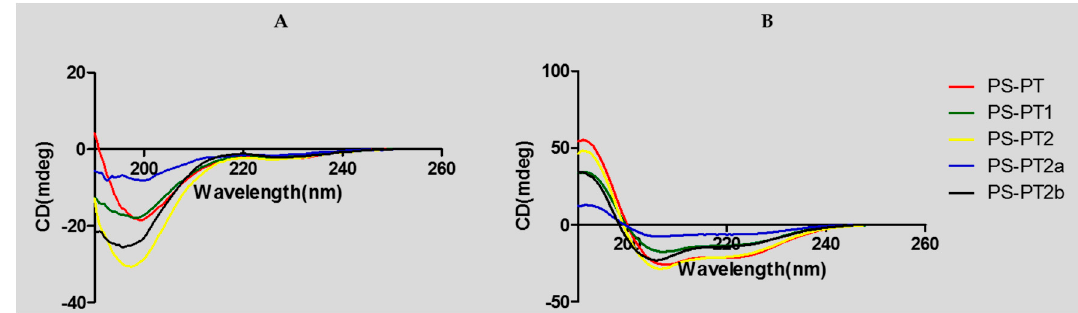
Figure 5. Circular dichroism (CD) spectra of PS-PT and its analogues (100 μ M) ( A ) in 10 mM ammonium acetate water solution and ( B ) in 50% 2,2,2-trifluoroethanol (TFE)/10 mM ammonium acetate water solution. Table 1. The amino acid sequences of PS-PT and analogues with their physicochemical parameters. The predicted secondary structures of PS-PT, PS-PT1, and PS-PT2 are shown below each peptide sequence, respectively. D -type amino acids are indicated in bold typeface.